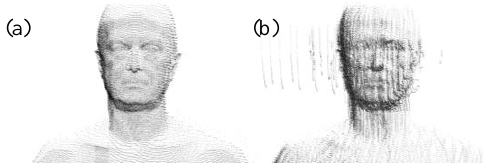
Figure 14. The drift error in the cinema parterre, with the sloping floor